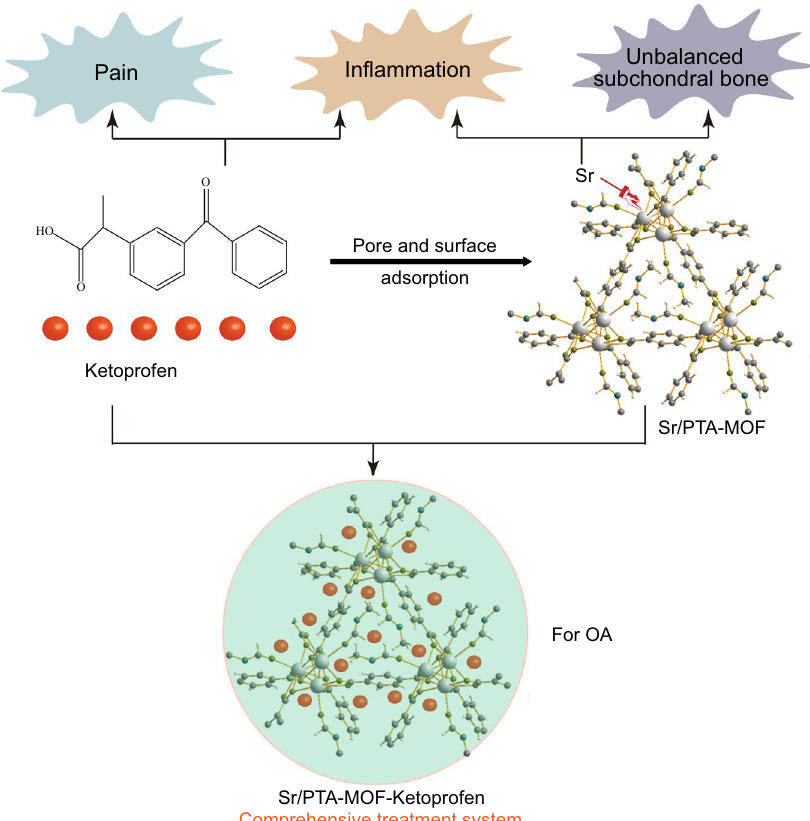
Figure 7. Sr/PTA-MOF-Ketoprofen was considered as comprehensive treatment system of